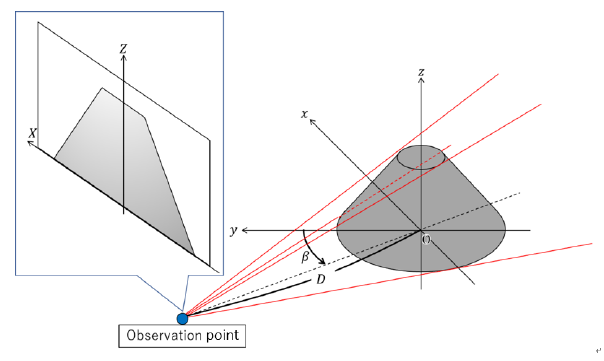
Figure 1. A schematic of radon transform and the definition of pa- rameters x , y , z , X , Z , β and D